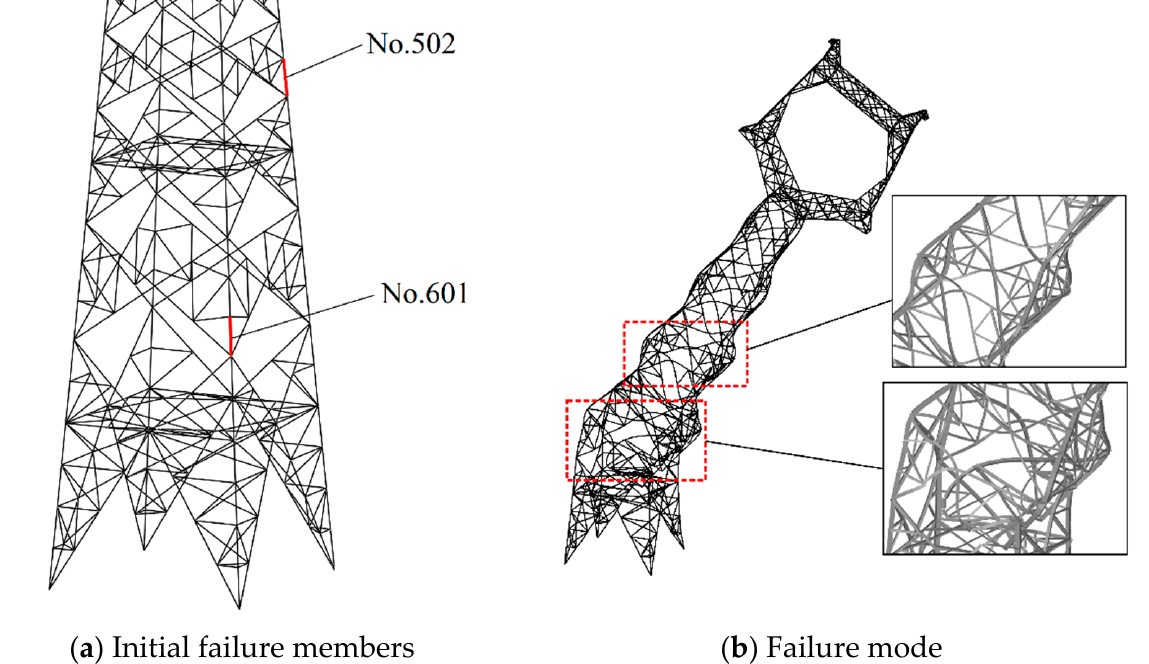
Figure 22. Initial failure members and failure mode of tower.